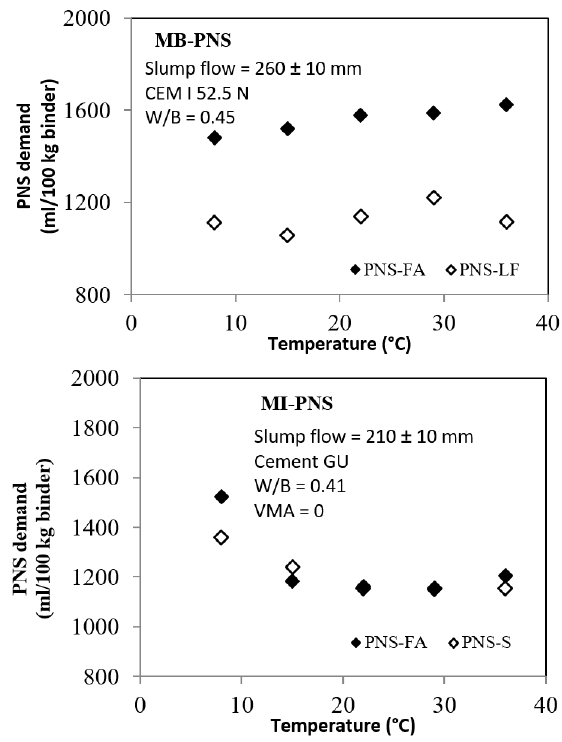
Figure 5. Effect of temperature on PNS demand of CEM